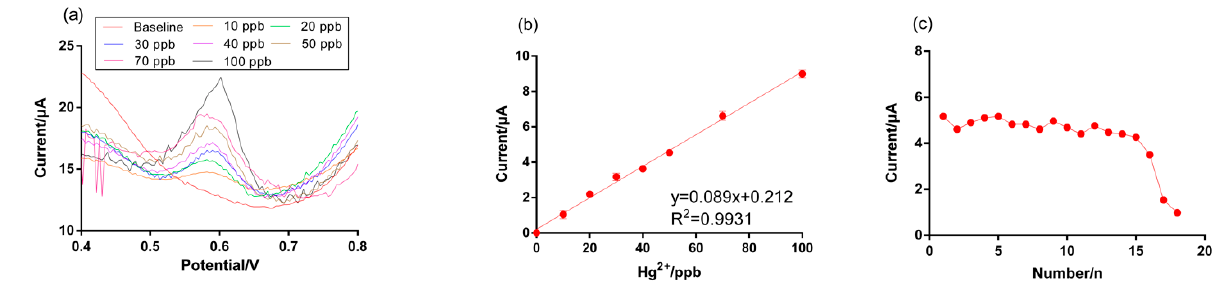
Figure 8. Hg 2+ detection using a AuNP-biopolymer-coated carbon SPE sensor in a real landfill leachate environment ( a ) SWASV, ( b ) calibration curves, and ( c ) reproducibility (Hg 2+ concentration is 50 ppb in landfill leachate (pH 3.0)). The error bars represent the standard deviation for the mean of the three replicate tests. Table 2. Comparison of Hg 2+ detection methods between AuNP-biopolymer-coated carbon SPE sensor and ICP-MS (n = 3).